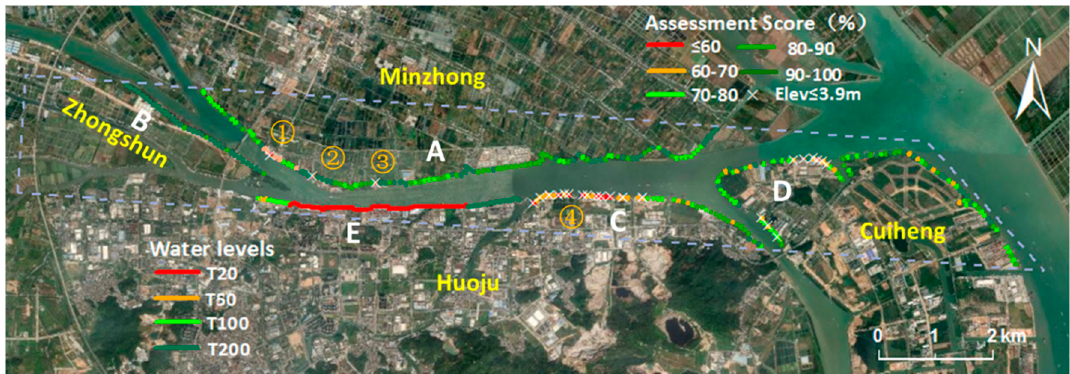
Figure 8. Spatial distribution of assessment results. The normalized assessment score is used for levees A, B, C and D. The water levels at the four return periods are illustrated to compare with the dock front elevation along the river of levee E. The number of ① to ④ represents the locations of levee crown modifications and notches.